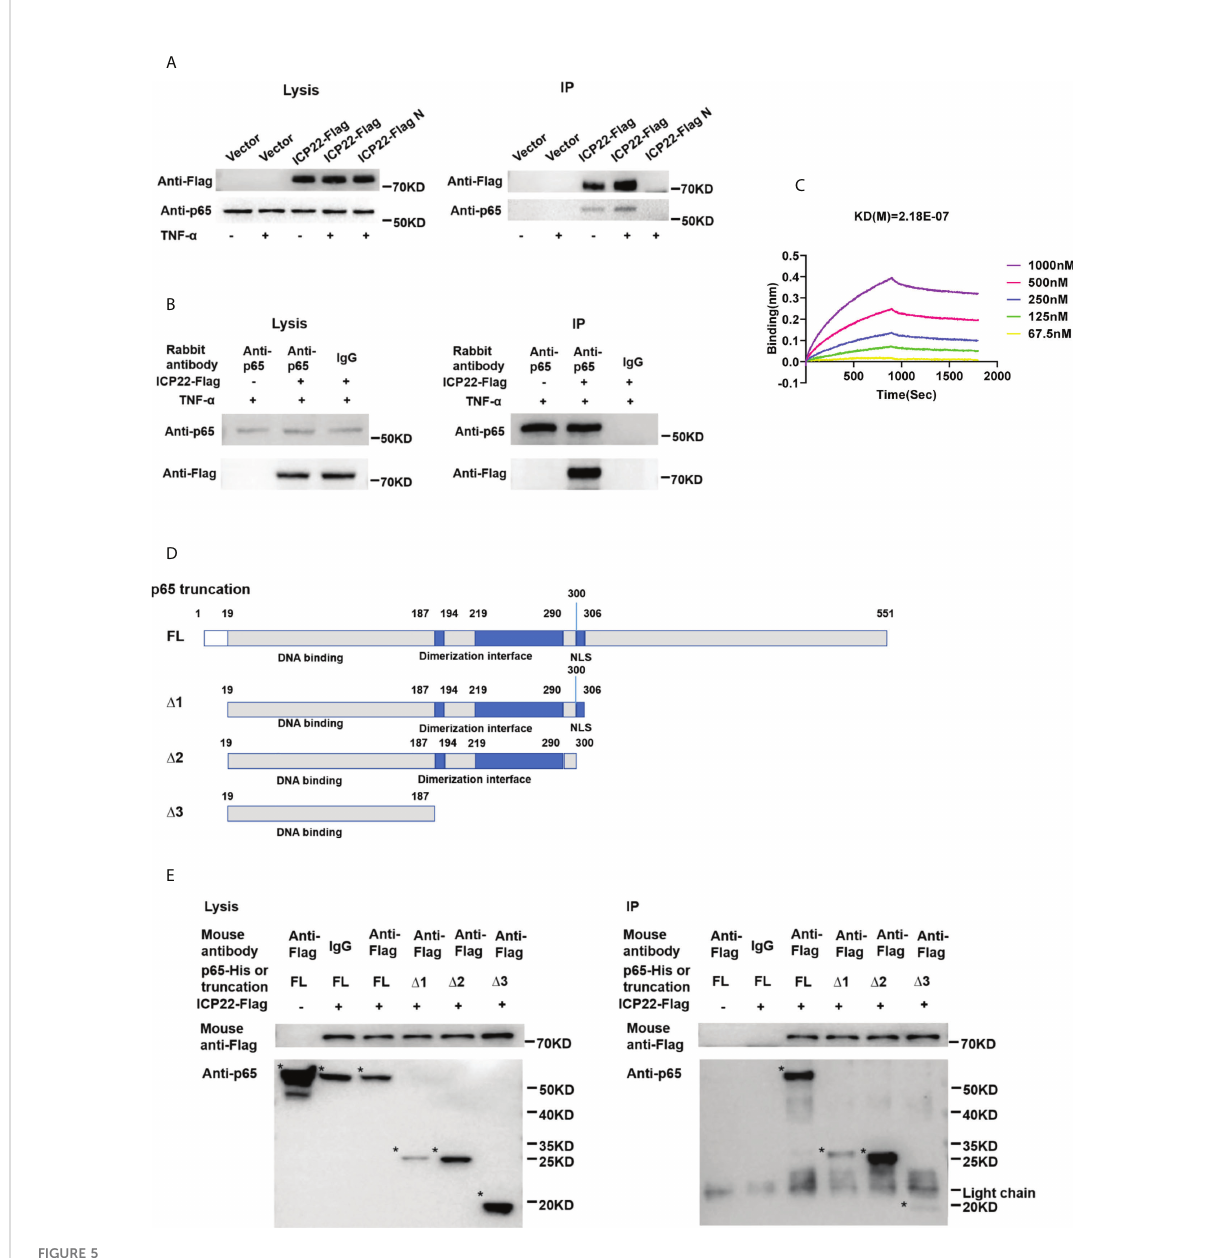
FIGURE 5 HSV-2 ICP22 directly interacts with p65. (A) HSV-2 ICP22 interacts with endogenous p65. (B) Endogenous p65 interacts with HSV-2 ICP22. HeLa cells seeded in the 6 well plates were transfected with empty vector or ICP22-expressing plasmid. At 24 h post-transfection, cells were mock-treated or treated with TNF- a (20 ng/ml) for 6 h. Cell lysates were then subjected to co-immunoprecipitation assays using the anti-Flag (A) or anti-p65 Ab (B) . The mouse (A) or rabbit (B) non-speci fi c antibody was used as negative control. ICP22 and p65 were detected by western blot using the anti-Flag or anti-p65 Ab, respectively. (C) HSV-2 ICP22 directly interacts with p65. The kinetics of binding was performed on a Forte-Bio Octet Red System. 5 m g/mL rabbit anti-p65 Ab was coupled to Protein A biosensors. 25 m g/mL recombinant p65 was bound to Biosenors and immersed in different concentration of ICP22 (62.5, 125, 250, 500 or 1000 nM) for association and disassociation. The response in nm shift was recorded as a function of time. KD (M) = 2.18E-07. (D) Schematic representation of p65 truncations. (E) HSV-2 ICP22 interacts with the three truncation mutants D 1, D 2 and D 3 of p65. Empty vector or ICP22-expressing plasmid and plasmid expressing full-length or truncated p65 were co-transfected into HEK 293T cells. At 24 h post-transfection, cells were mock-treated or treated with TNF- a (20 ng/ml) for 6 h. Cell lysates were then subjected to co-immunoprecipitation assays using the anti-Flag mAb. ICP22, truncated p65 were detected by western blot using the anti-Flag or anti-p65 Ab, respectively. Asterisk indicated the locations of proteins. One representative experiment out of three is